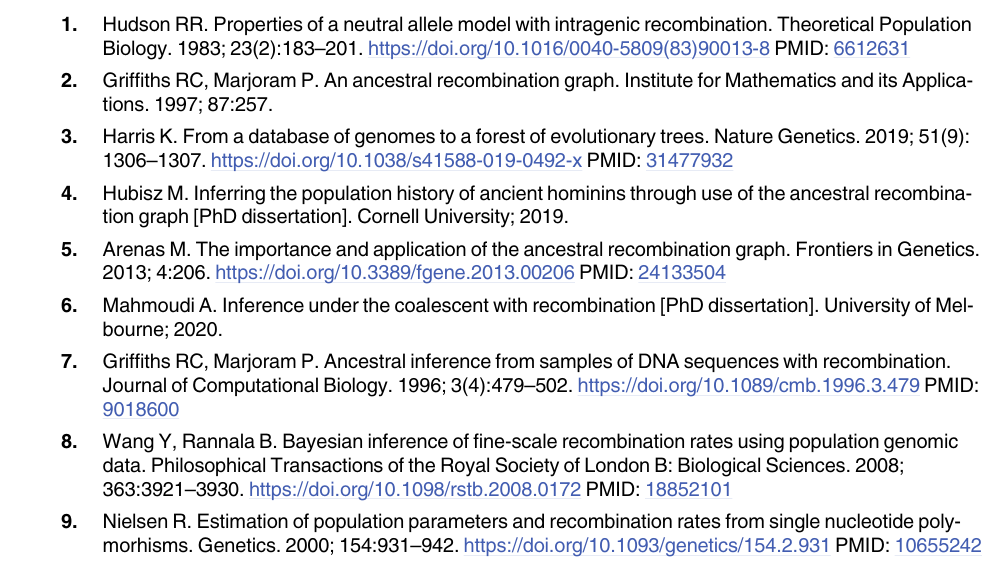
S6 Fig. True (black dashed line) TMRCA, in units of 10 4 generations, and posterior mean (red line) inferred by ARGinfer (left) and ARGweaver (right) for a randomly-selected, sim- ulated data set with R = 2. Red shading shows 50% credible intervals. S7 Fig. True (red dashed line) allele ages, in units of 10 4 generations, and posterior mean (blue line) inferred by ARGinfer (left) and ARGweaver (right) for the simulated data set used in S6 Fig. Along the x axis SNPs are ordered by increasing value of true allele age. Blue shading shows 50% credible